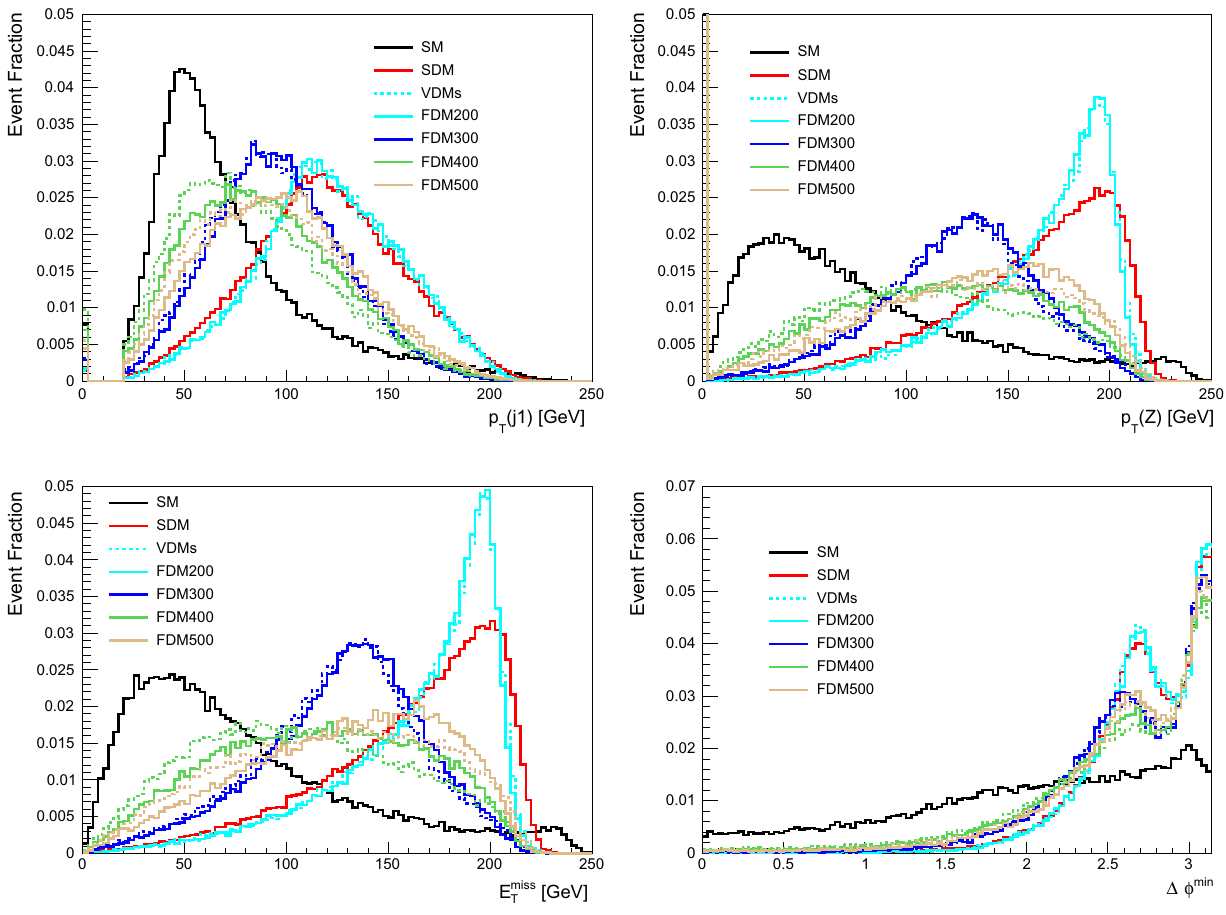
Fig. 5 Kinematic variables distributions after detector simulation. The meaning of the lines is the same as in Fig. 3